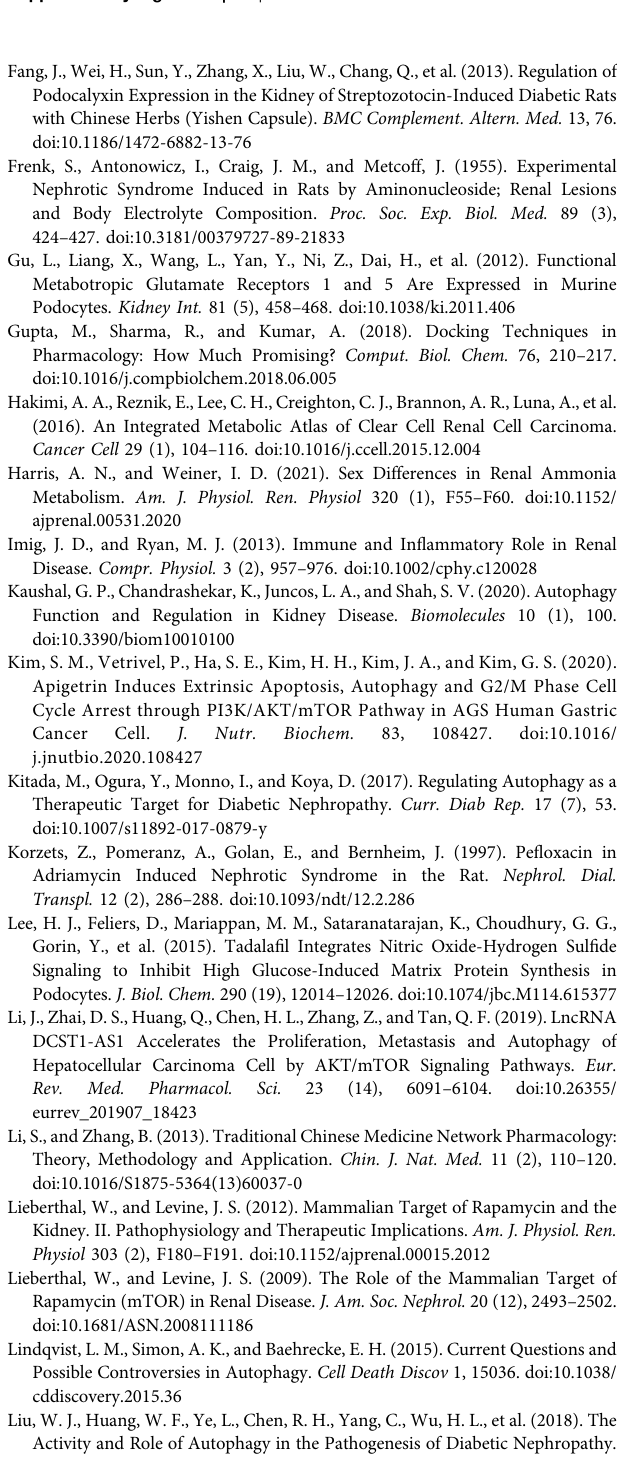
Supplementary Figure S1 | Extraction ion chromatogram of each QRKSG component. Supplementary Figure S2 | The peak area distribution from the 30 compounds identi fi ed in QRKSG Supplementary Figure S3 | Graphical